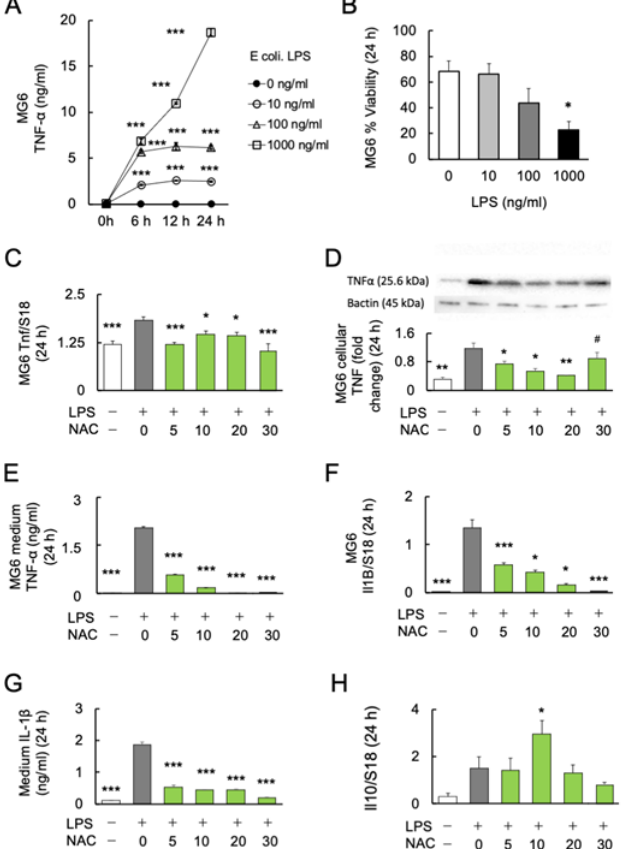
Figure 1. Effects of NAC on LPS-induced cytokines production in MG6 cells. ( A ) The dose–response relationship and time course of LPS on TNF- α production (n = 6). *** p < 0.001, vs. control. ( B ) The dose–response relationship of LPS with the viability of MG6 cells after 24 h (n = 6). * p < 0.05, vs. control. ( C ) The dose–response relationship of NAC with LPS-induced Tnf mRNA expression in MG6 cells after 24 h (n = 6). * p < 0.05, *** p < 0.001, vs. LPS only. ( D ) Gel images and bar graph of the signal intensities determined by western blotting of MG6 cells using anti-TNF α antibodies after 24 h treatment with LPS and NAC, relative to the averaged signal intensity of β -actin (n = 3). * p < 0.05, ** p < 0.01, vs. LPS only. # p < 0.05, vs. Con. ( E ) The dose–response relationship of NAC with LPS-induced TNF- α synthesis in MG6 cells after 24 h (n = 6). *** p < 0.001, vs. LPS only. ( F )